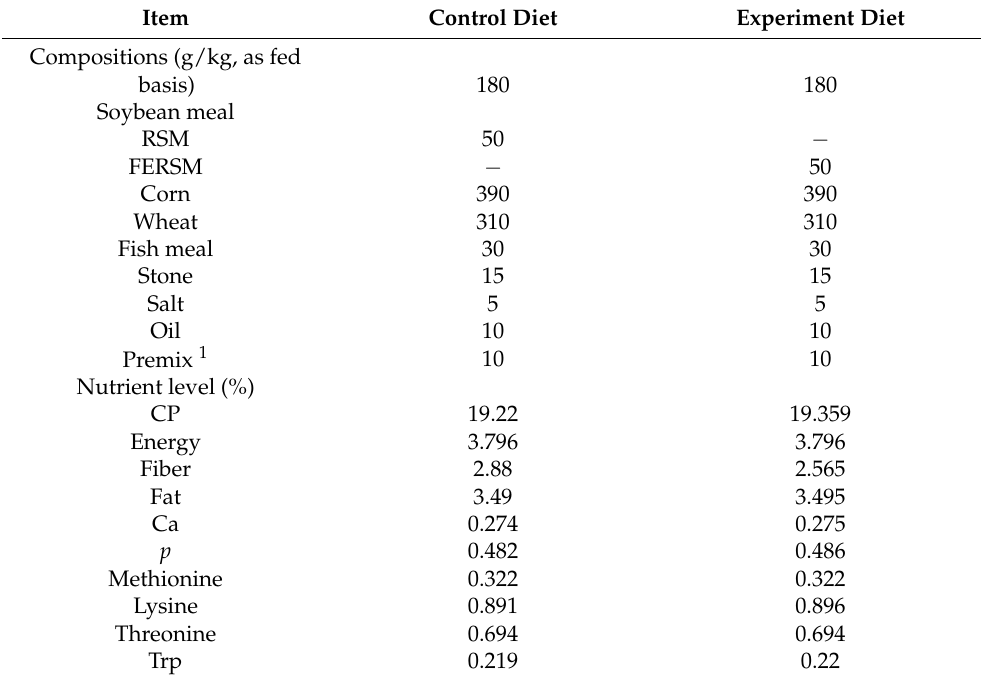
Table 1. Ingredients and compositions and nutrient levels of the control diet and experimental